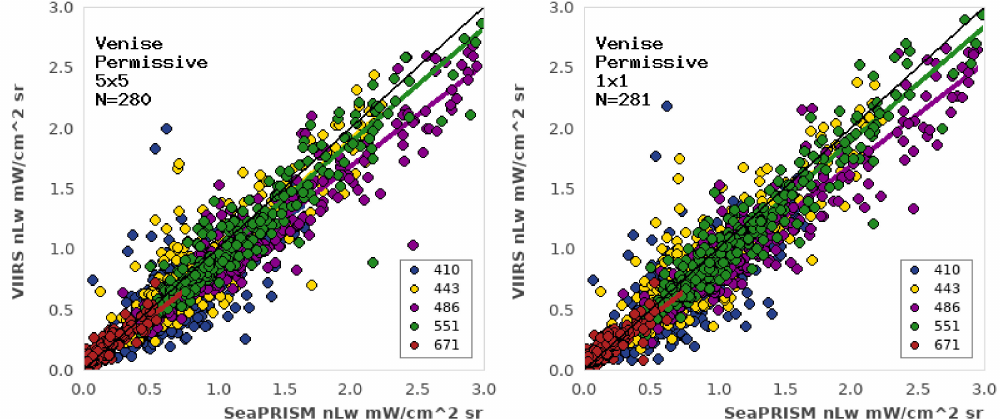
Figure 5. Venise–VIIRS comparison, June 2014–May 2019. Permissive protocol. Left: 5 × 5 box; right: center pixel only. There is a reduction in some outliers in the 1 × 1